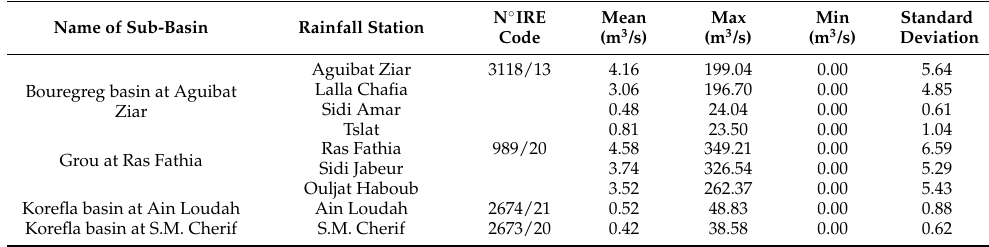
Table 3. Statistical characteristics of runoff data by sub-basin for the period from 1 September 2016 to 31 August